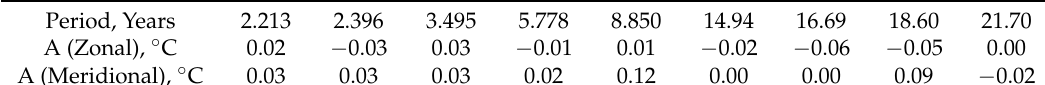
Table 13. Regime-dependent component amplitudes A in a simulation of the AMO after removing a ~60-year oscillation. The AMO lags tidal components by 0.04 years.